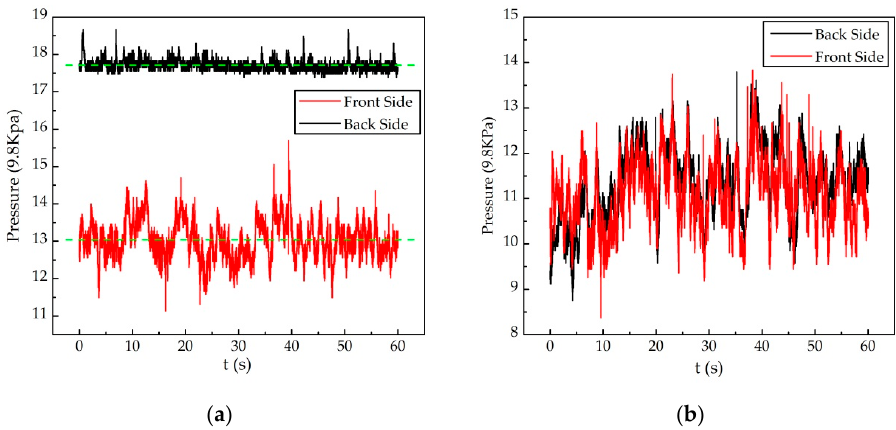
Figure 16. Hydraulic pressure histories measured at test points e and f under working Condition 1. ( a ) drainage failure plate; and ( b ) self-drainage plate. Max value: 64.4 KPa